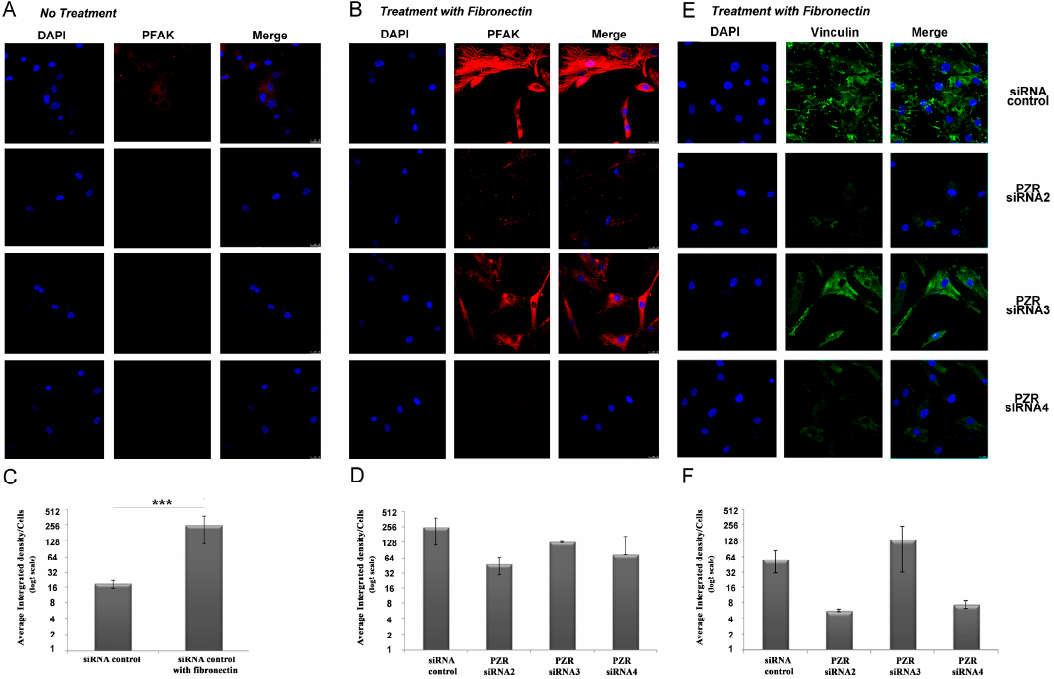
Figure 5. Knockdown of hPZR shows reduced phosphorylation of FAK and reduced vinculin in migrating hBM MSCs. ( A ) Representative confocal microscopy images of PFAK (red) and DAPI (blue) staining in migrating hBM MSCs ( A ) without or ( B ) with fibronectin and treated with siRNAs control, PZR2 , PZR3 , and PZR4 . Original magnifications, 63 × . ( C ) Quantification of PFAK expression in siRNA control treated hBM MSCs migrating without or fibronectin. The average integrated density of PFAK / the number of cells is shown as means ± S.E.M. per 100 cells counted (*** p < 0.001; Student’s t -test). ( D ) Quantification of PFAK in hBM MSCs migrating on fibronectin after treatment with siRNA control, PZR2 , PZR3, or PZR4. The average integrated density of PFAK / the number of cells is shown as means ± S.E.M. per 100 cells counted. ( E ) Representative confocal microscopy images of hBM MSCs migrating on fibronectin and stained for vinculin (green) and DAPI (blue) after treatment with siRNAs control, PZR2, PZR3, or PZR4 . Original magnifications, 63 × ( F ). The average integrated density of vinculin / the number of cells is shown as means ± S.E.M. per 100 cells